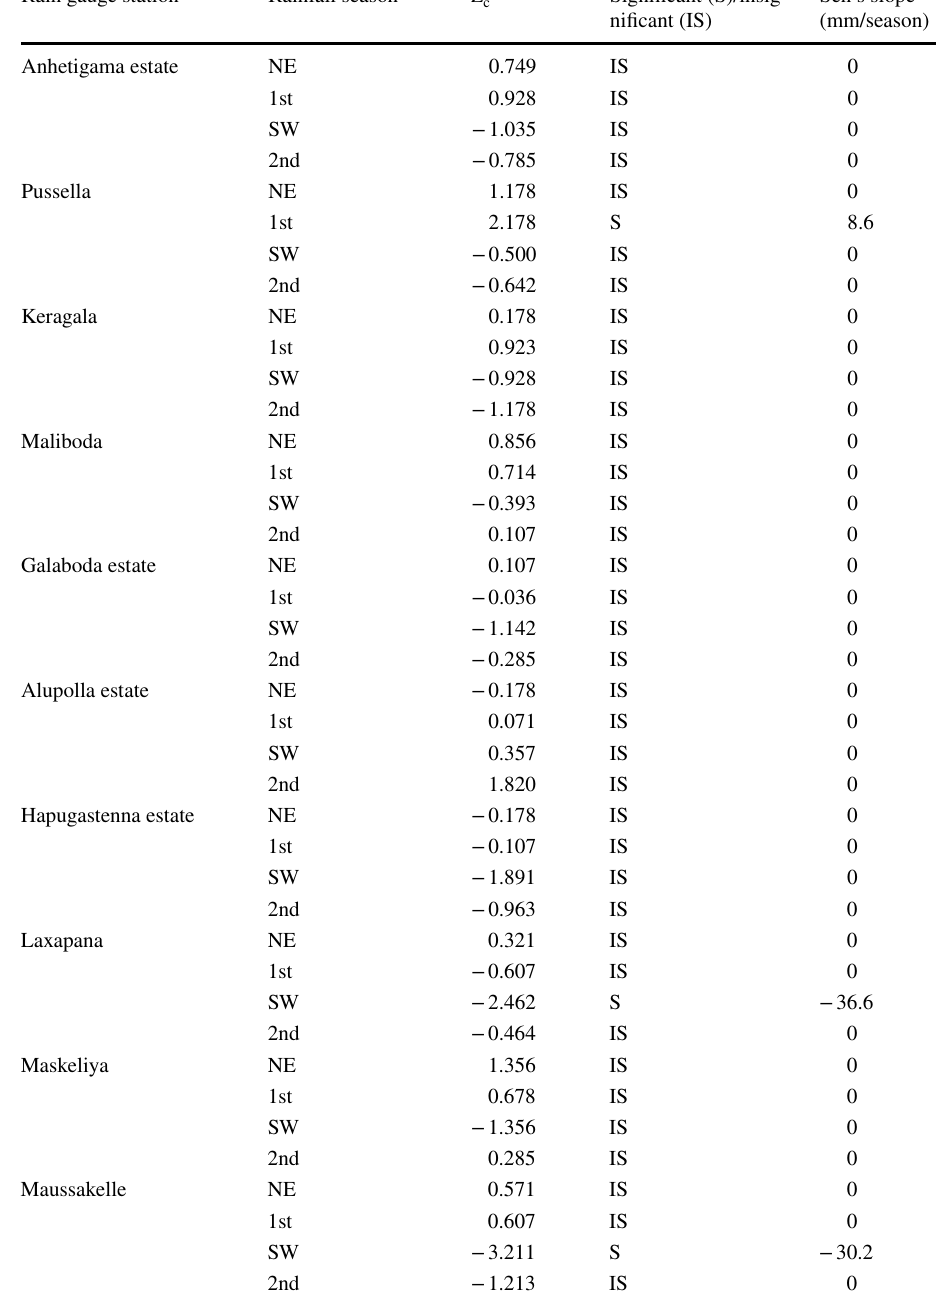
Table 2 Mann–Kendall test and Sen’s slope estimator test results for seasonal